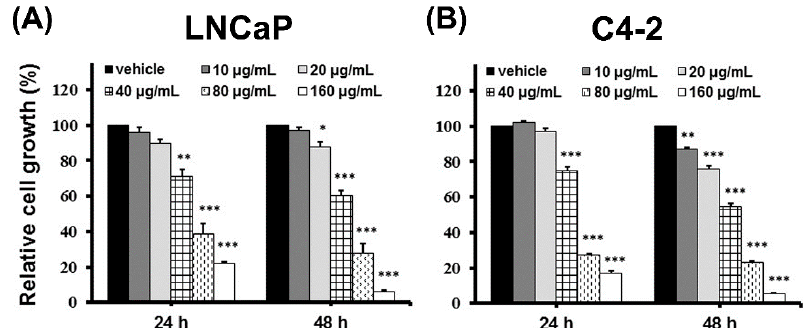
Figure 1. Davallia formosana (DF) ethanol extract (DFE) suppresses prostate cancer (PCa) cell growth. ( A ) LNCaP and ( B ) C4-2 cells were treated with vehicle or DFE (10, 20, 40, 80, and 160 µg/mL) for 24